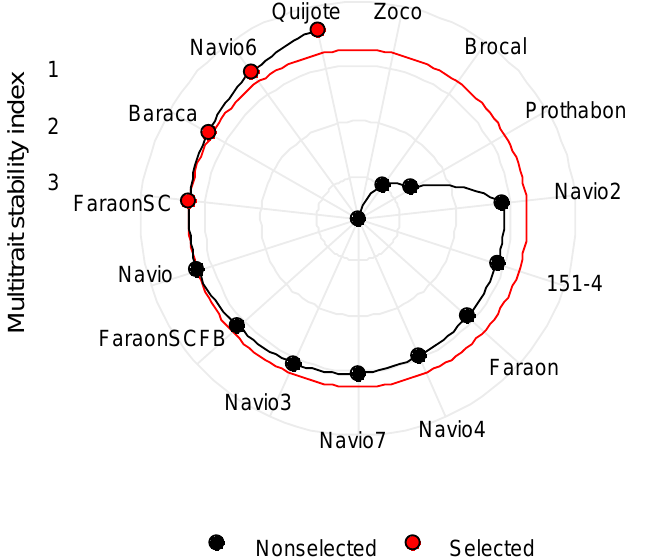
Figure 6. Selected accessions using MTSI for grain yield, and broomrape infection assigning a selection intensity of 25%.